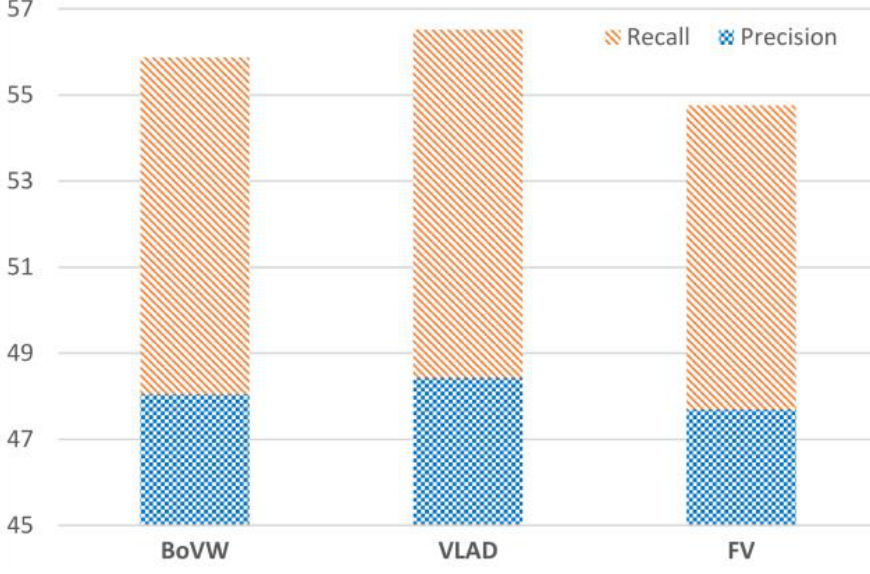
Figure 4. Precision and recall yielded using the three aggregation methods: BoVF, VLAD, and FV.